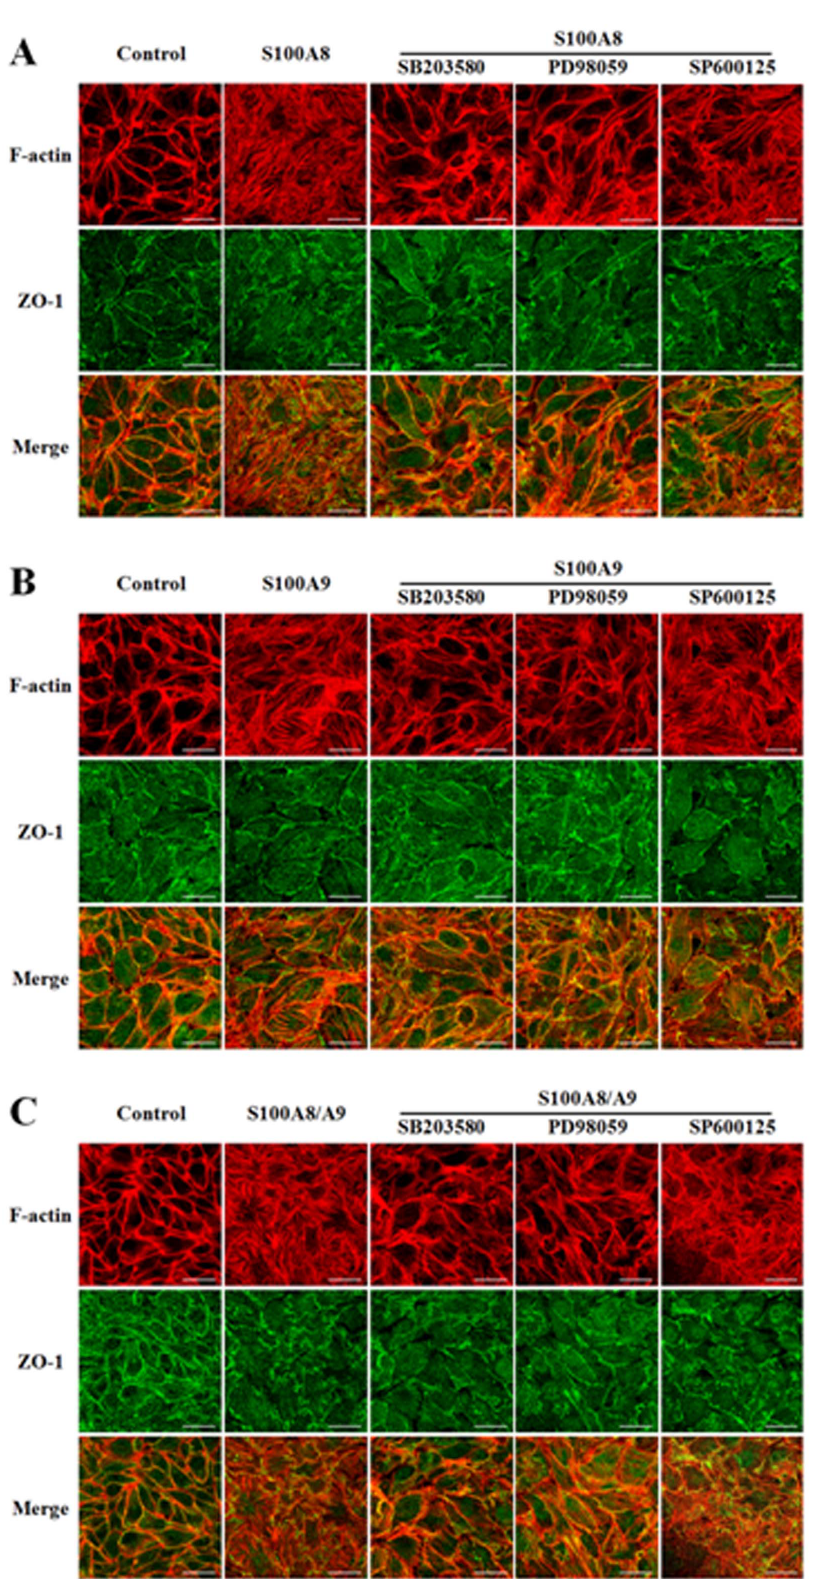
Figure 5. S100A8, S100A9 and S100A8/A9 induced stress fiber formation and disrupted ZO-1 by a p38 and ERK1/2 dependent mechanism. HUVECs were stimulated with S100A8 (2.0 m g/mL) ( A ), S100A9 (2.0 m g/mL) ( B ) or S100A8/A9 (2.0 m g/mL) ( C ) for 120 min, with or without 60 min pre-incubated with SB203580 (10 m M), PD98059 (50 m M) and SP600125 (10 m M), which were used as standard inhibitor for p38, ERK1/ 2 and JNK, respectively. Cells were fixed and double immunofluorent staining was performed according to the protocol described in Materials and